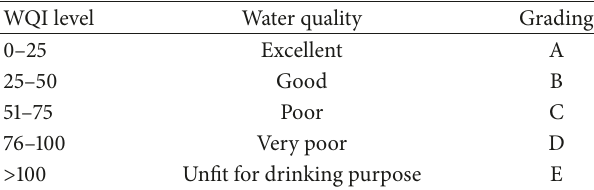
Table 7: Water quality classification based on